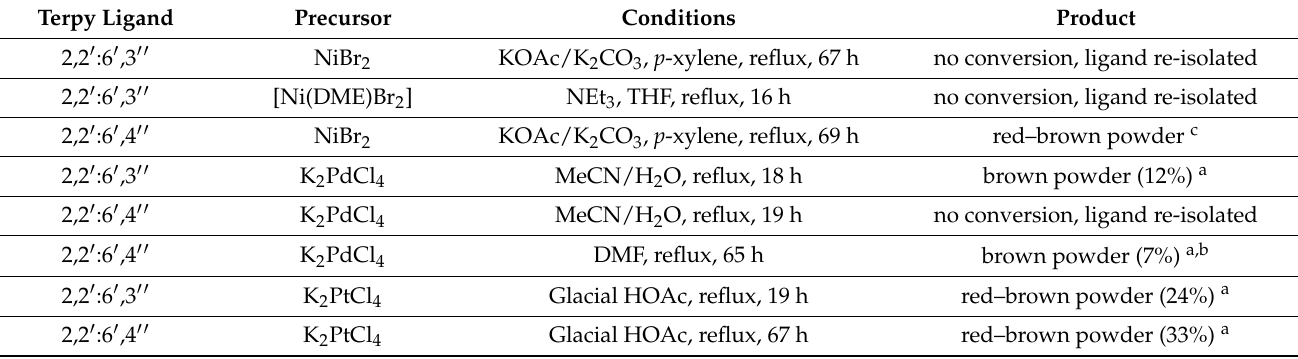
Table 1. Overview of attempted complex syntheses using 2,2 (cid:48) :6 (cid:48) ,3 (cid:48)(cid:48) - and 2,2 (cid:48) :6 (cid:48) ,4 (cid:48)(cid:48) -terpy ligands. Terpy